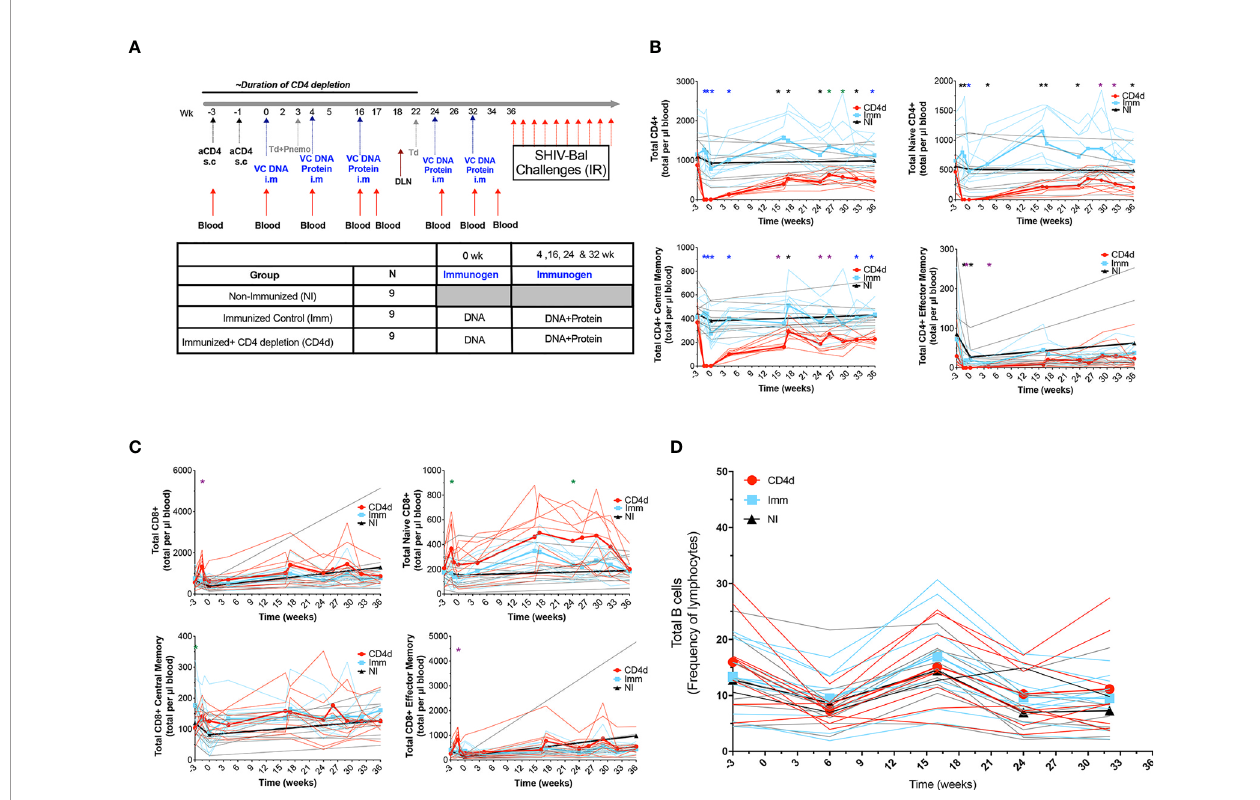
FIGURE 1 | Frequencies of immune cell subsets in CD4 depleted and vaccinated rhesus macaques. (A) Immunization schedule: 27 adults rhesus macaques were assigned to this study and divided into two groups of nine for immunizations and the third group with nine macaques without immunization. All 18 rhesus macaques received VC10014 DNA plasmids and were then boosted i.m with co-immunization of VC10014 DNA plasmids and proteins in adjuplex. Nine rhesus macaques received CD4R1 during the priming phase. Flow cytometric analysis of longitudinal distribution of CD4+ (B) and CD8+ (C) T cells and total CD19+CD20+ B cells (D) . Red=CD4 depleted (CD4d) group, turquoise =Immunized (Imm) group, black=Non-Immunized (NI) group. Thin lines represent individual animals, thick lines indicated group mean. Signi fi cance determined by the unpaired t-test comparing Imm and CD4d groups and are indicated as follows: p ≤ 0.001, *p ≤ 0.005, p ≤ 0.01, p ≤